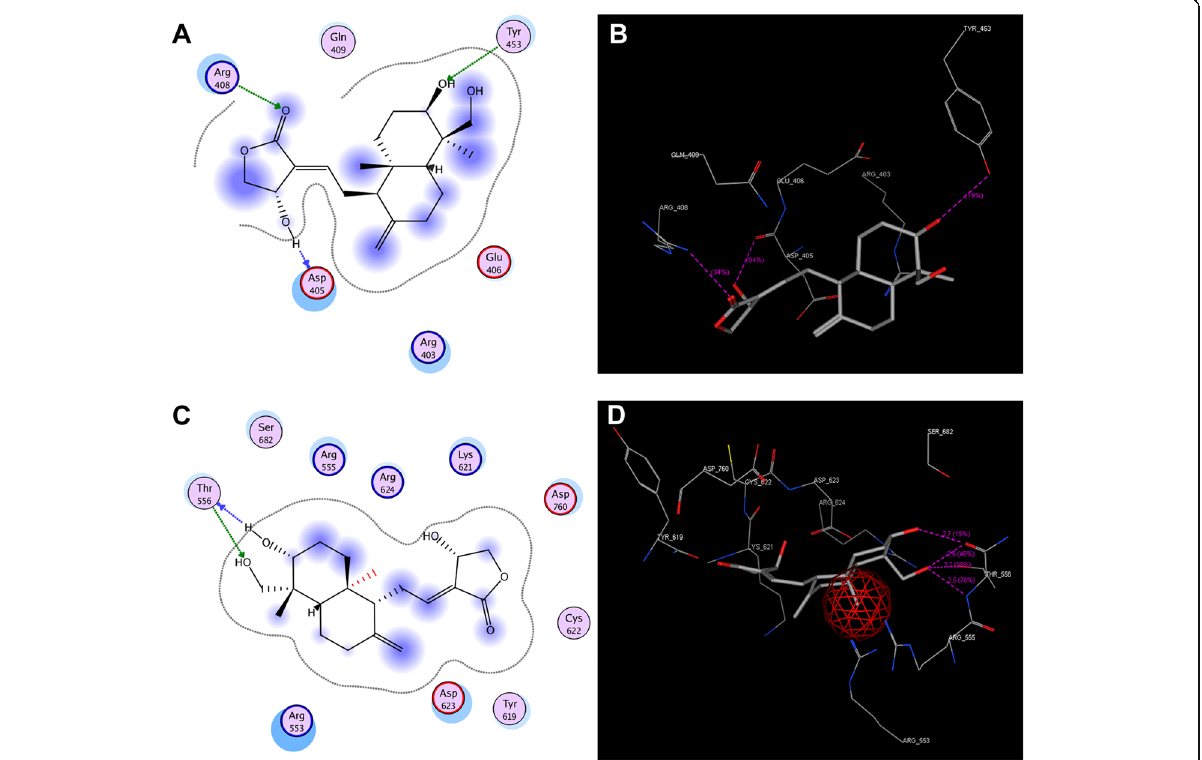
Fig. 4 Docking of andrographolide with spike RBD and RdRP (NSP12) of SARS-CoV-2. A Spike RBD acting as a receptor to dock andrographolide projected 2-dimensionally. B Spike RBD 3-dimensional field of image showing interacting residues and the H-bonds. C 2-Dimensional portrait of RdRP (NSP12) receptor docked with andrographolide. D 3-Dimensional representation of RdRP (NSP12) interacting residues and its